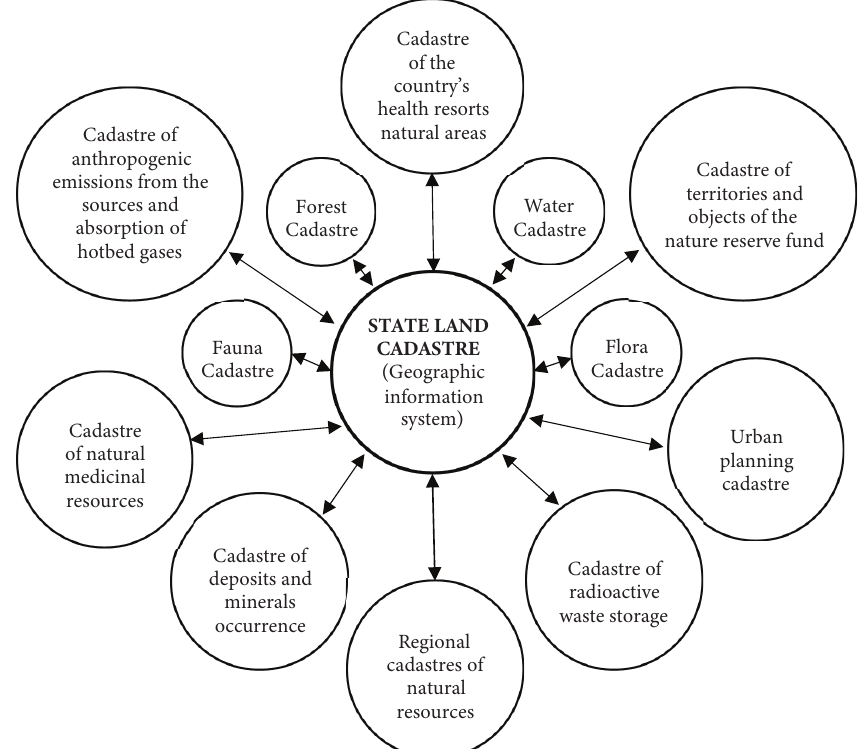
Figure 1. Cadastral system of